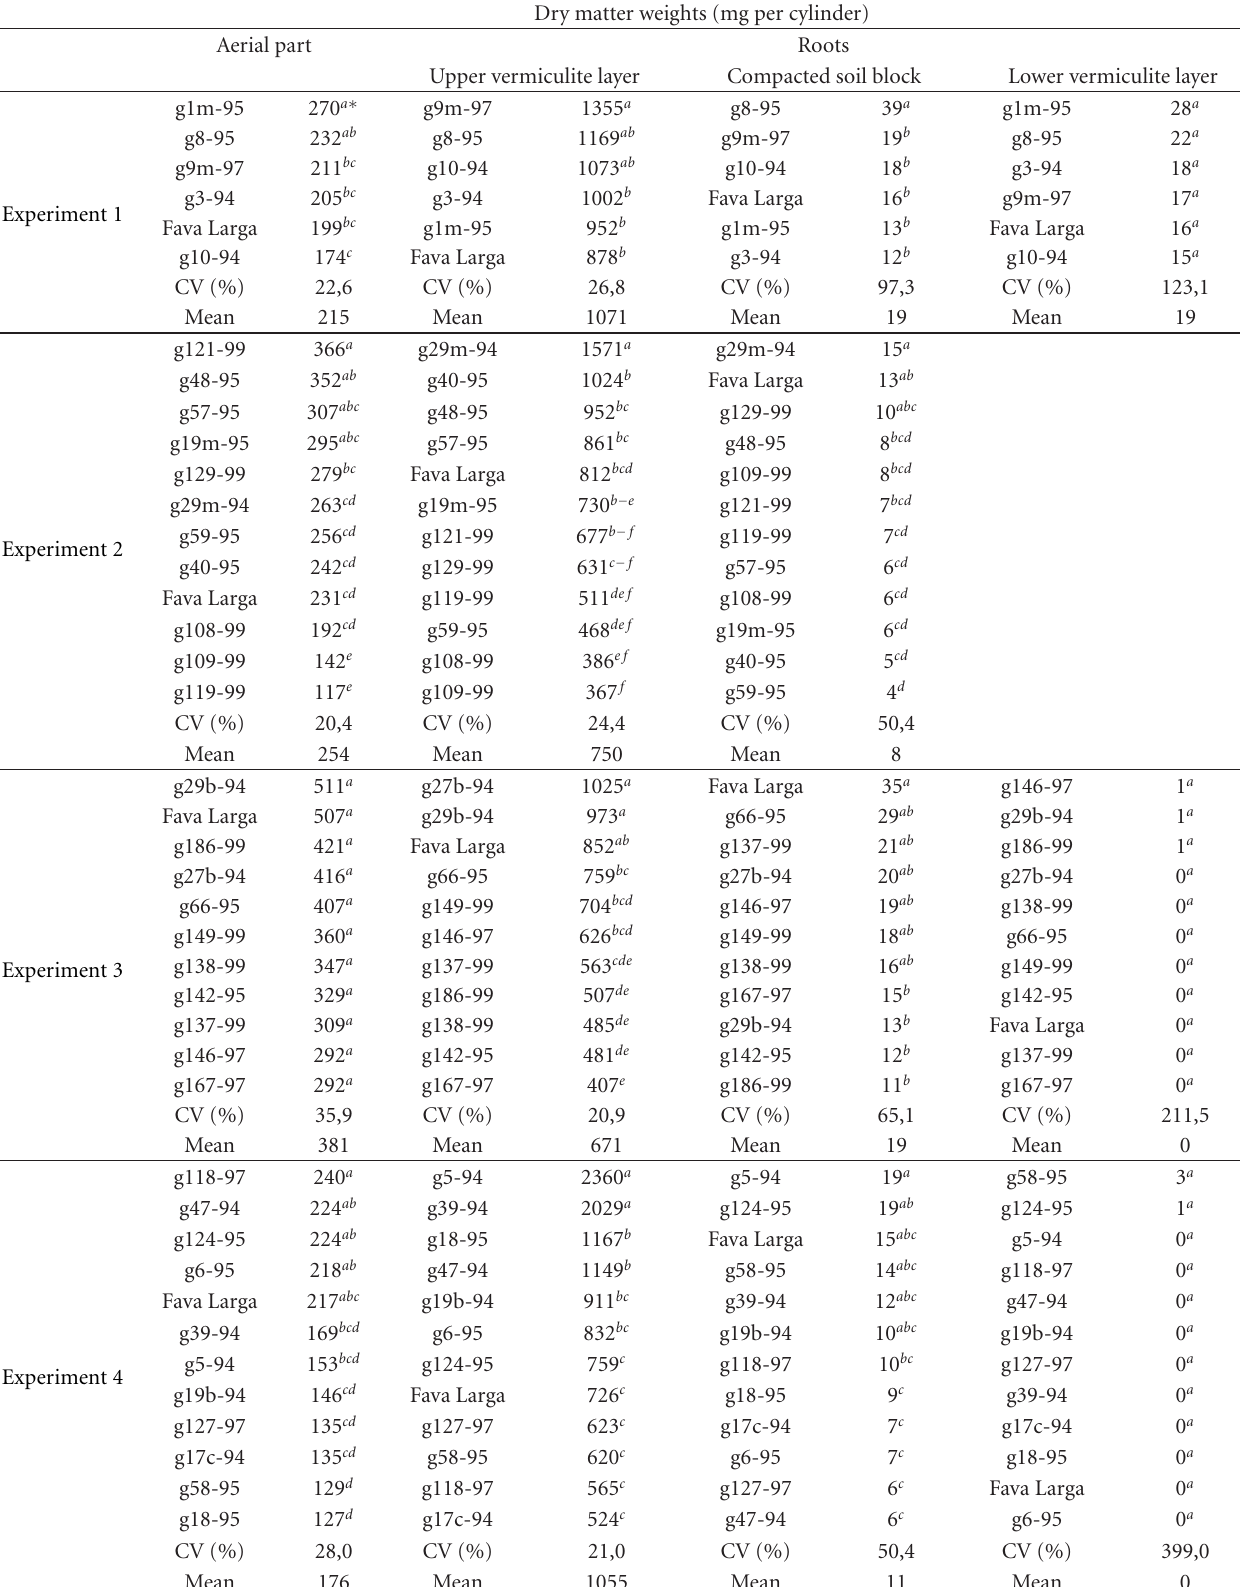
Table 1: Dry matter weights of the aerial part of the plants and of the roots in the upper and lower vermiculite layers and in the compacted soil layer, of forty pigeon pea genotypes and of the Fava Larga